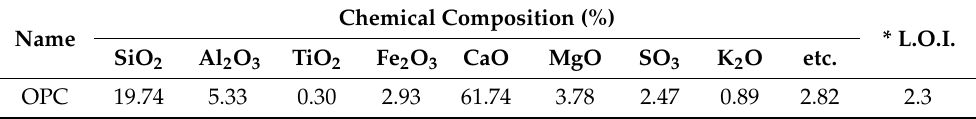
Table 1. Chemical composition of cement.